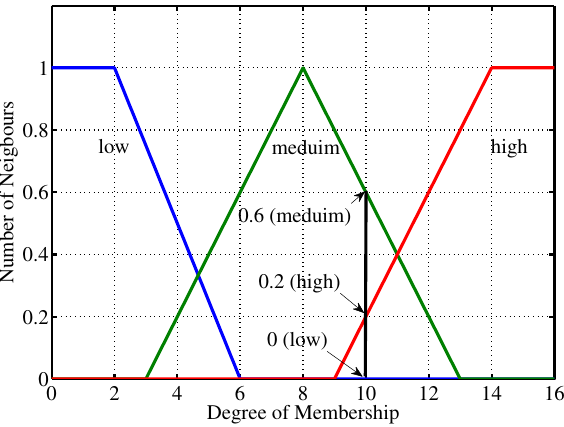
Figure 6. Fuzzification of the node degree input